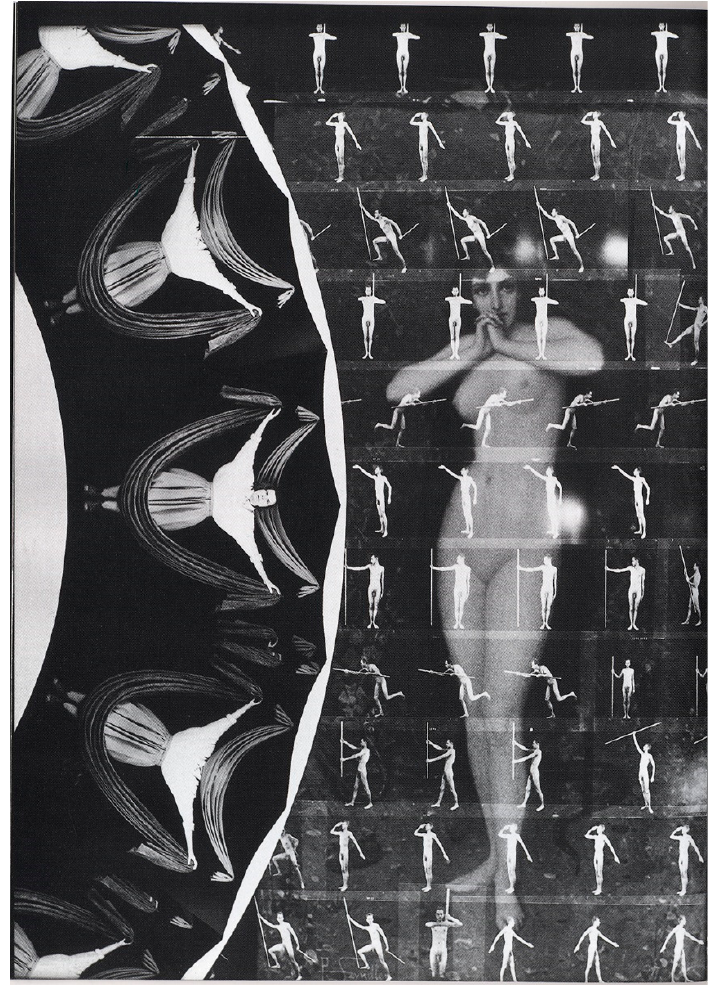
Figure 6. Kulik, guide , 1997. Pantaleon Szyndler, Eve , 1902, with Zbigniew Libera in nude poses. Indeed as a counterpoint there are many female images in All the Missiles . . . : still frames from TV programmes showing female dancers, the Miss America contest, or